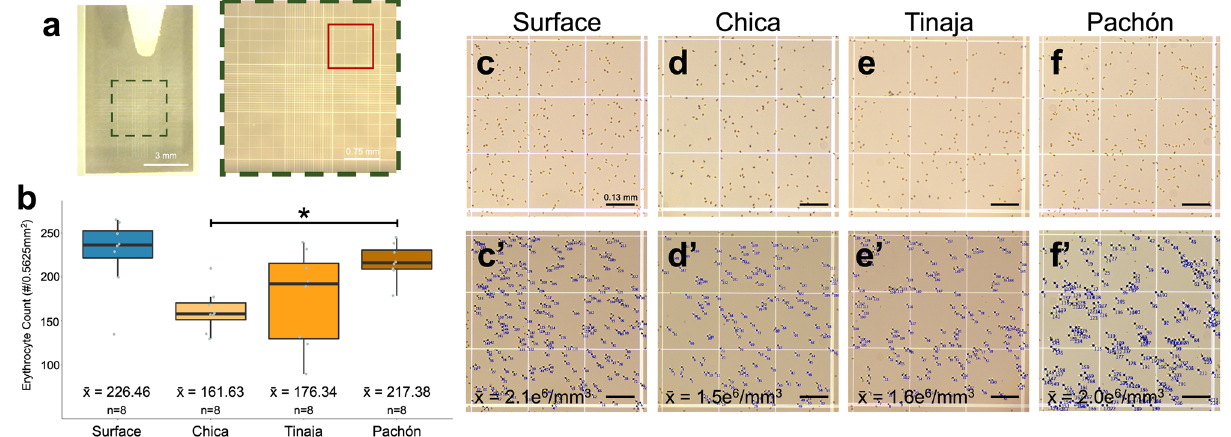
Figure 3. Erythrocyte density is comparable across Astyanax morphotypes. We determined the density of erythrocytes in a standard blood volume using a hemocytometer ( a ). Although statistical difference was detected for the Chica population (p < 0.0023), mean erythrocyte density was comparable across morphotypes ( b ). Erythrocytes were stained with Acridine Orange, visualized under light microscopy ( c – f ) and counted using ImageJ 29 (v2.0.0) ( c ′ – f ′ , scale bar 130 µm). Two outliers were detected (the lowest value in surface and highest in Chica). Removal of these outliers resulted in a statistically significant difference between Chica and Surface (Table